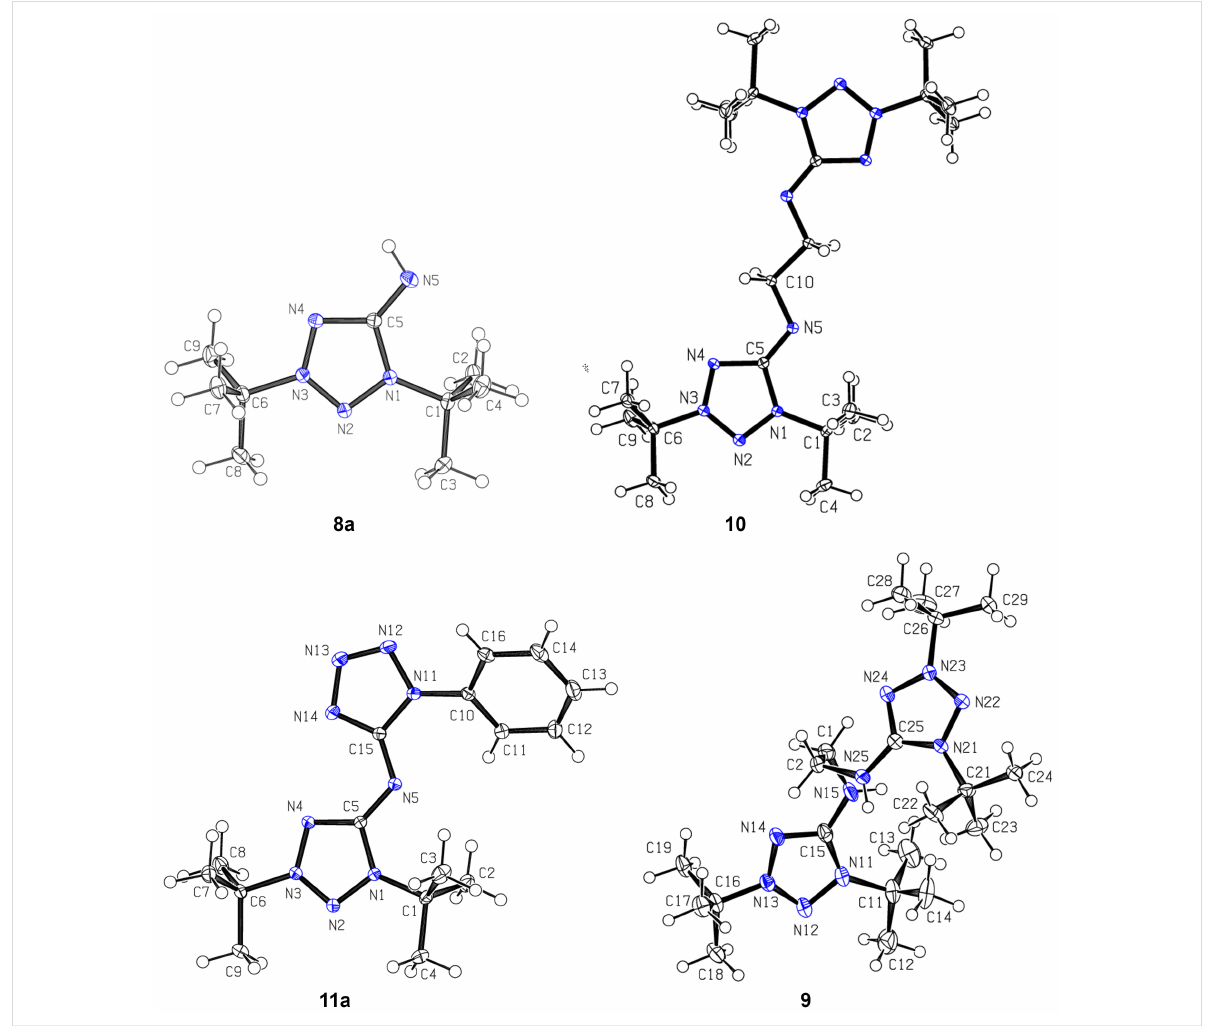
Figure 2: Molecules of compounds 8a , 10 , 11a , and the bistetrazolium cation 9 , with displacement ellipsoids drawn at the 50% probability level. The hydrogen atoms are shown as spheres of arbitrary radii. The atom numbering is done for the asymmetric unit.